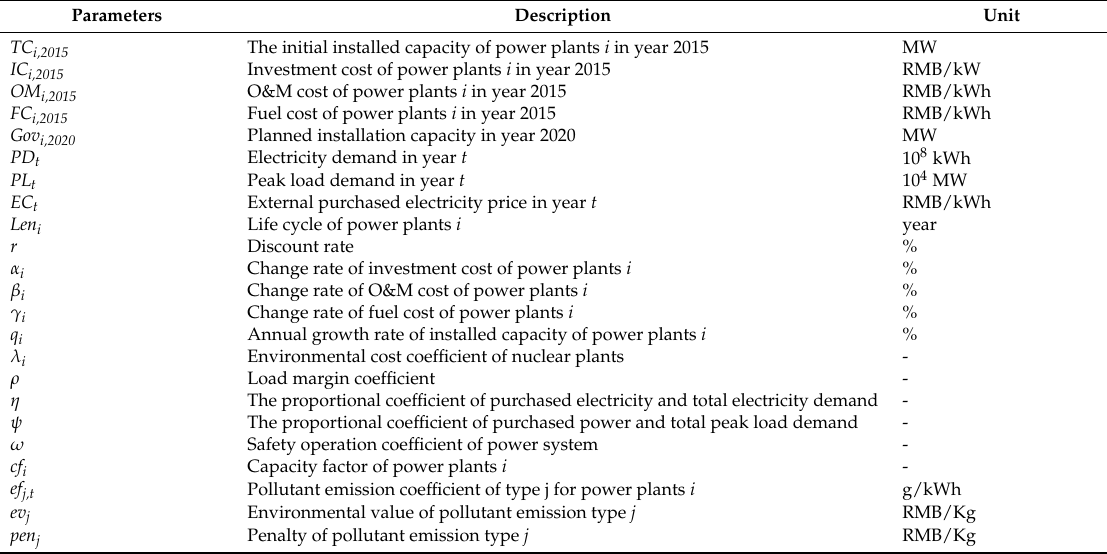
Table 2. List of parameters.